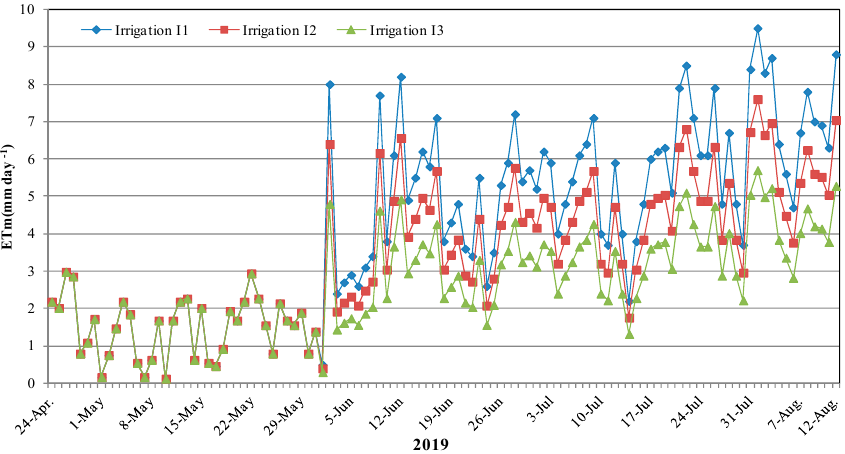
Figure 5. Daily fiber hemp evapotranspiration under the three irrigation regimes in 2019. In 2018, the IWUE values (Equation (2)) were 0.67 kg m − 3 and 2.0 kg m − 3 for variants I 2 and I 3 , respectively, but the values of 9.0 kg m − 3 , 20.7 kg m − 3 , and 22.0 kg m − 3 were cal- culated for the variants I 1 , I 2 , and I 3 (Equation (3)), respectively (Table 7). The IWUE value for the I 1 variant could not be calculated (Equation (2)) as the bark yield was lower than that obtained for I 0 (Table 3). The ETWUE values (Equation (4)) were 0.28 kg m − 3 for the I 2 variant, and 1.18 kg m − 3 , 1.61 kg m − 3 , 2.12 kg m − 3 , and 1.92 kg m − 3 (Equation (5)) for I 1 , I 2 , I 3 , and I 0 , respectively (Table 7). The K y value was 0.22 for the entire growing season (Table 7).